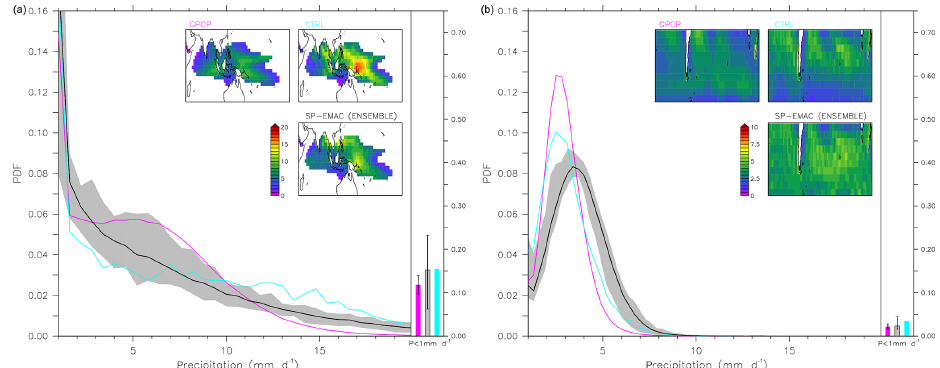
Figure 5. PDFs of monthly precipitation rates for the warm pool region (a) and Southern Ocean midlatitudes (b) compared to 30 years of GPCP data (same as in Table 2). Inserted maps show yearly averaged rates in mmd − 1 for the specified geographical regions as pointed out in the text. Line colours correspond to the colours above the inserted panels. On the right-hand side of each figure, the fraction of non- precipitating cells (below 1mmd − 1 ) is displayed, including the interannual variability for the GPCP data and the variability induced by different SP-EMAC configurations (uncertainty bars). Note that the x axis begins at 1mmd − 1